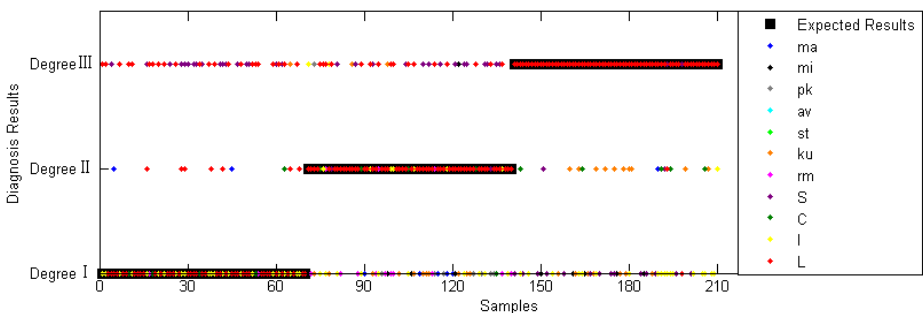
Figure 11. Diagnosis results of ball fault severity estimation based on the BPNN_BA network.